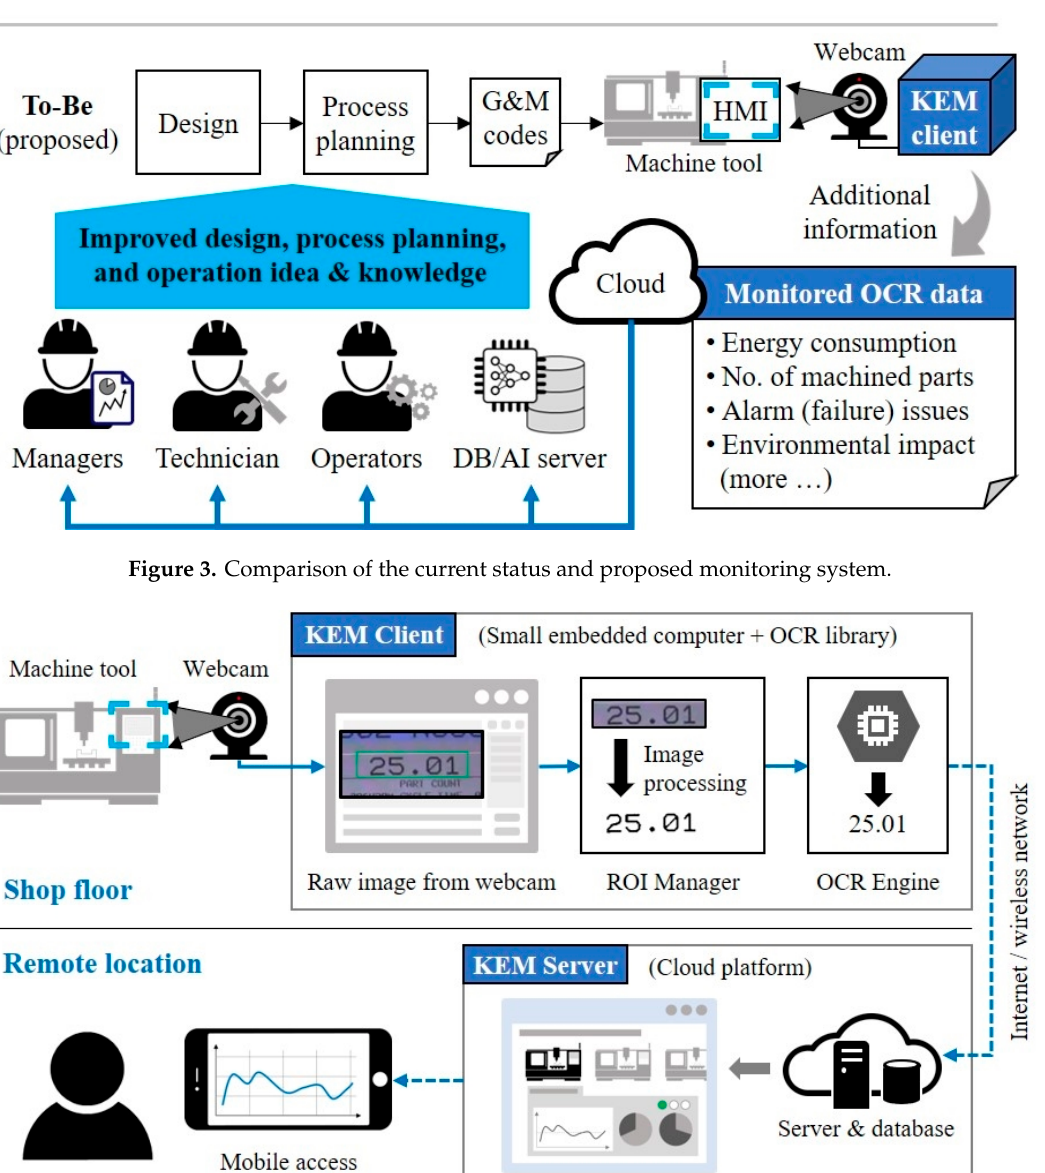
Figure 4. Configuration of the proposed KEM (keep an eye on your machine) monitoring system.